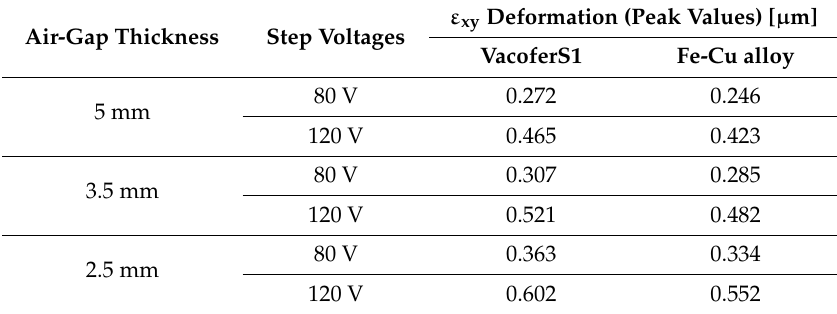
Figure 14. Maximum deformation according to the supplied voltage and the air-gap thickness of the Fe–Cu alloy magnetic non-linear and conductive material: step voltage of ( a ) 80 V, and ( b ) 120 V. Table 3 indicates the peak values of the maximum deformation according to the air gap and the applied step voltage magnitude for the Vacofer S1 and Fe–Cu alloy materials. Table 3. Peak values of the ε xy deformation according to the air-gap thickness and the voltage magnitude for the Vacofer S2 and Fe–Cu alloy